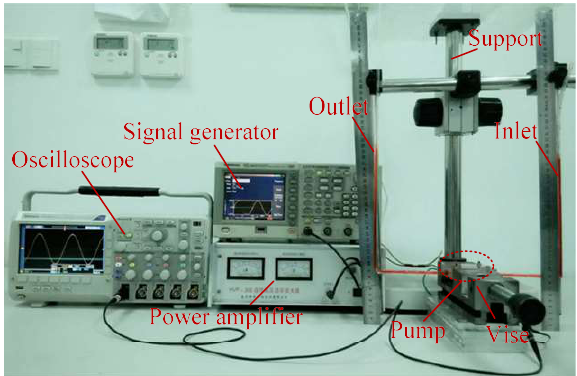
Figure 9. The experimental platform for the pressure-difference test.